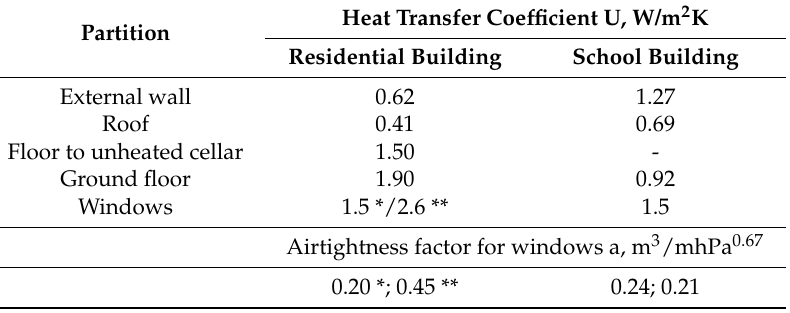
Table 1. Values of heat transfer coefficient of partitions in the studied buildings, including aging effects and thermal